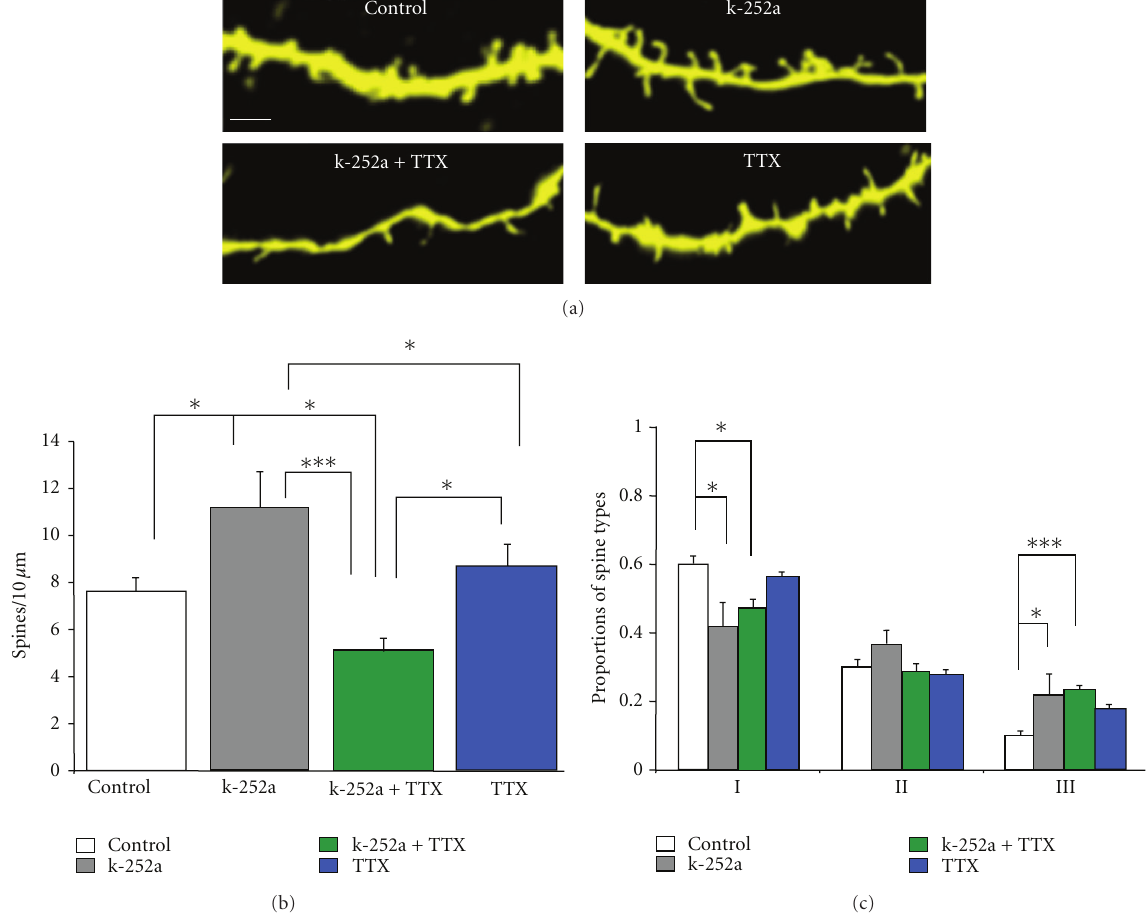
Figure 3: Role of neuronal activity in k-252a’s e ff ects on dendritic spine density and morphology. (a) Representative examples of dendritic segments of CA1 pyramidal neurons maintained in serum-containing media (SM) and treated with k-252a (200 nM), TTX (1 µ M), or both k-252a and TTX for 48hrs (scale bar represents 2 µ m). (b) Dendritic spine density expressed per 10 µ m of apical dendrite. (c) Proportion of each morphological type of dendritic spines, expressed as a fraction of the total spine population. ∗ P < 0 . 05, ∗∗ P < 0 . 01, and ∗∗∗ P < 0 . 001, after a one-way